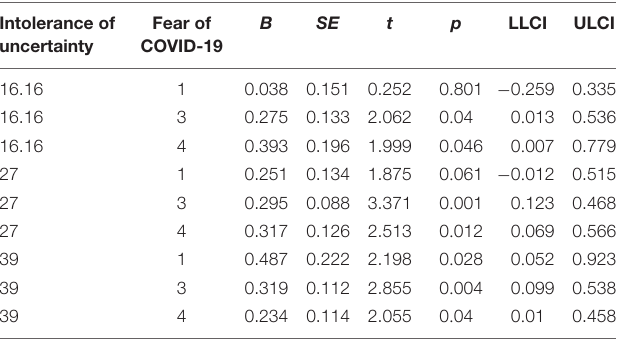
TABLE 8 | Conditional effects of Perceived job insecurity at specific values of two moderators. Intolerance of